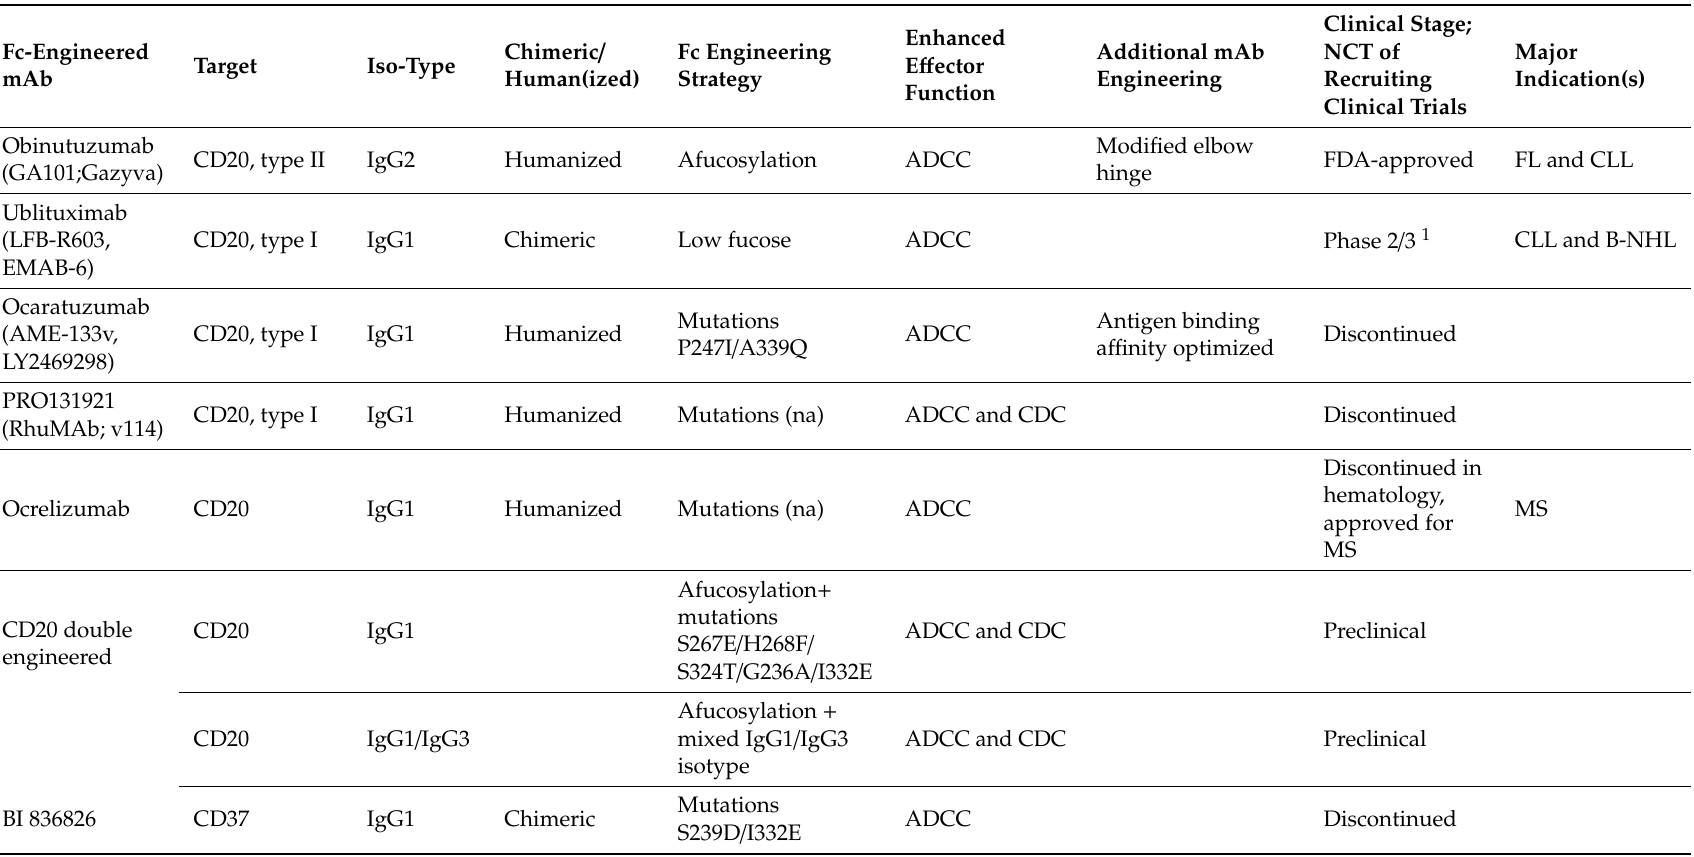
Table 1. Fc-engineered monoclonal antibodies (mAbs) with enhanced mAb e ff ector function in (pre-) clinical development for chronic lymphocytic leukemia (CLL), B-cell non-Hodgkin lymphoma (B-NHL), and multiple myeloma